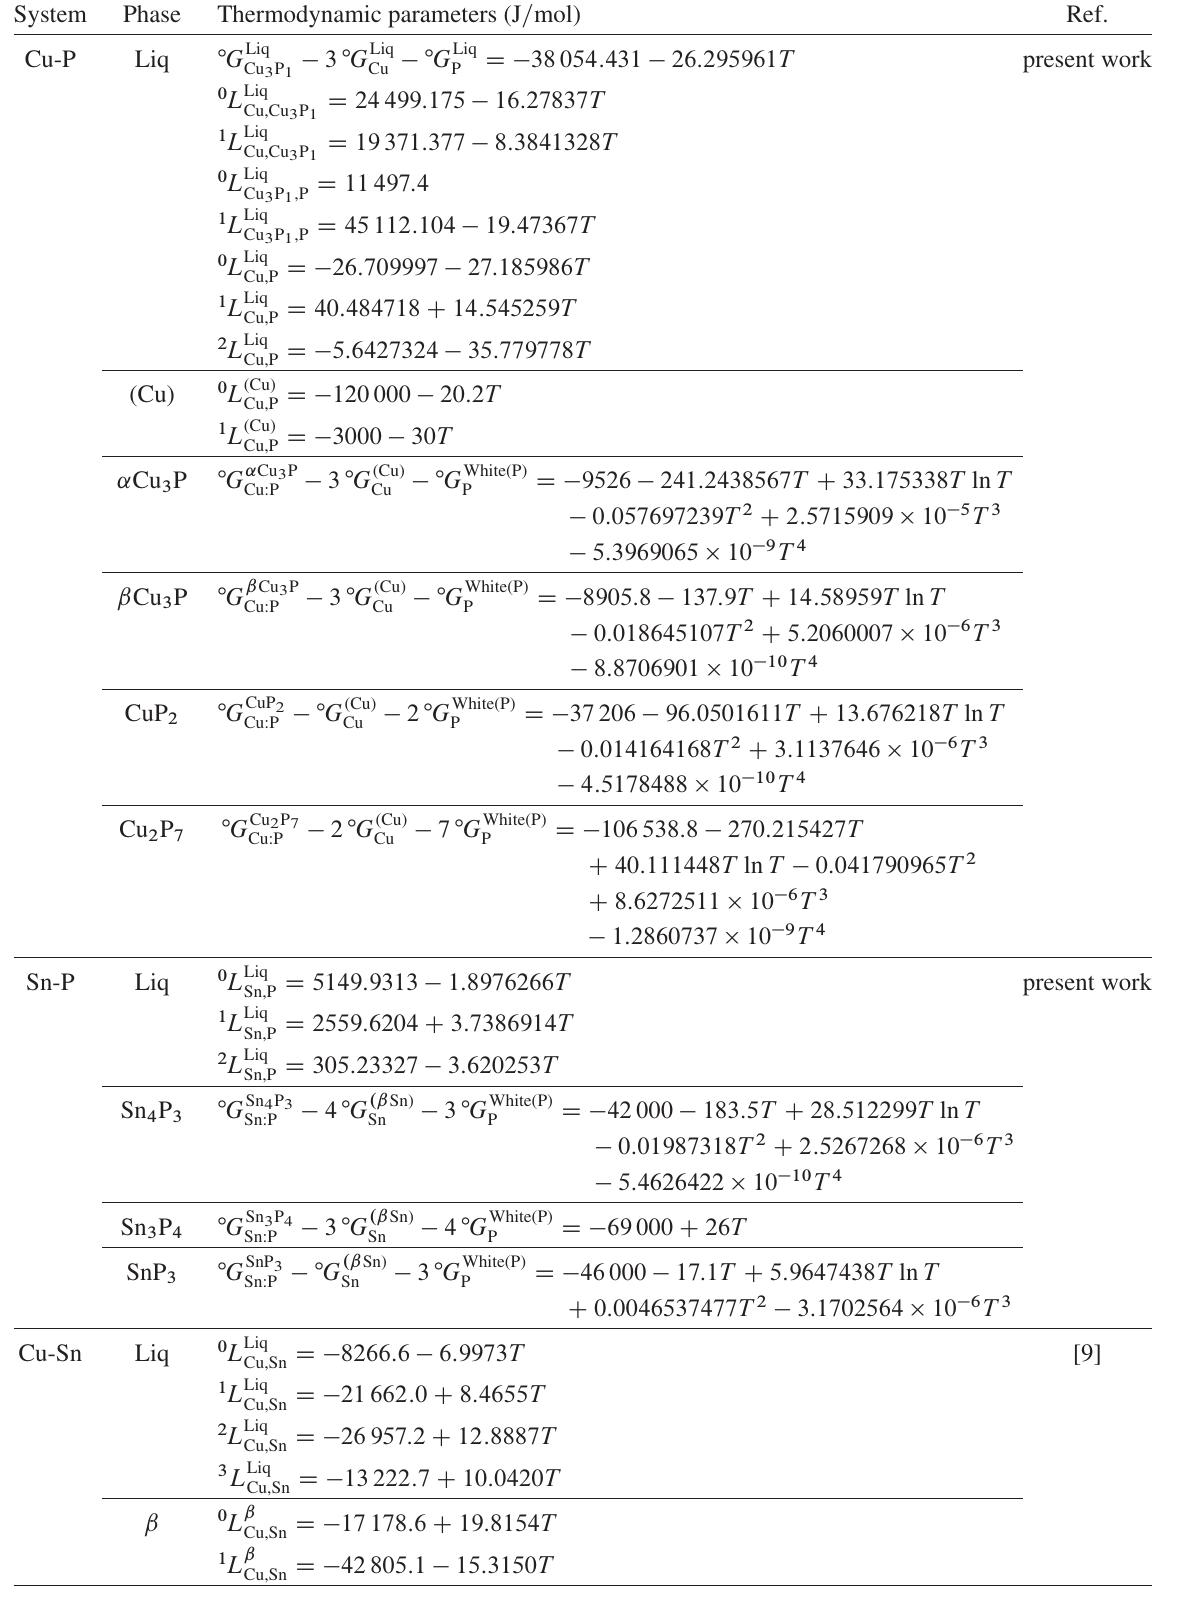
Table 3. Optimized thermodynamic parameters of the binary and ternary